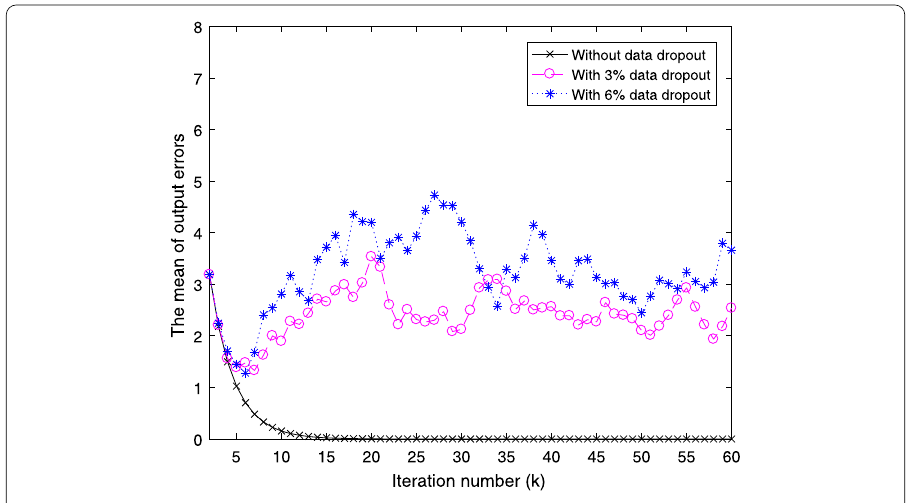
Figure 2 The mean of output errors without